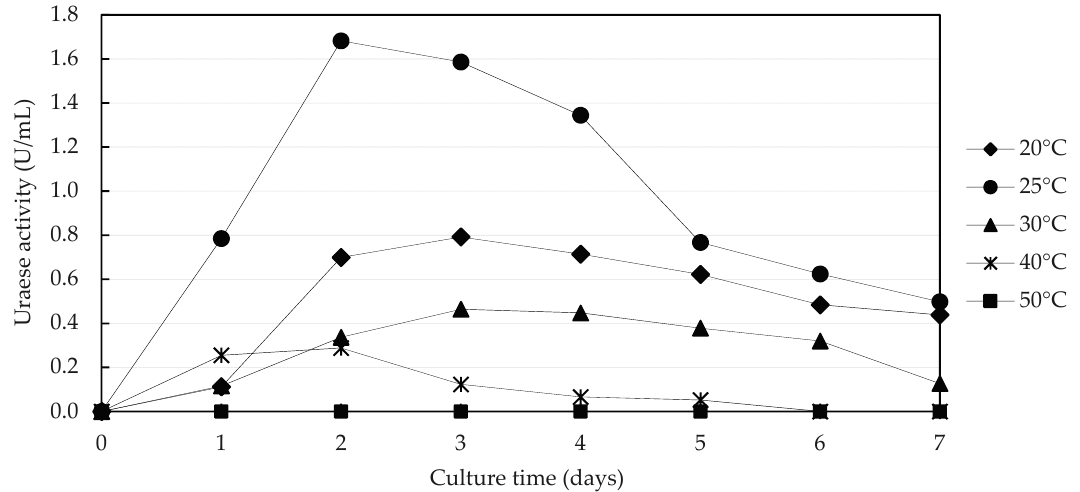
Figure 5. Variation of urease activity of Sporosarcina sp. at different temperatures.